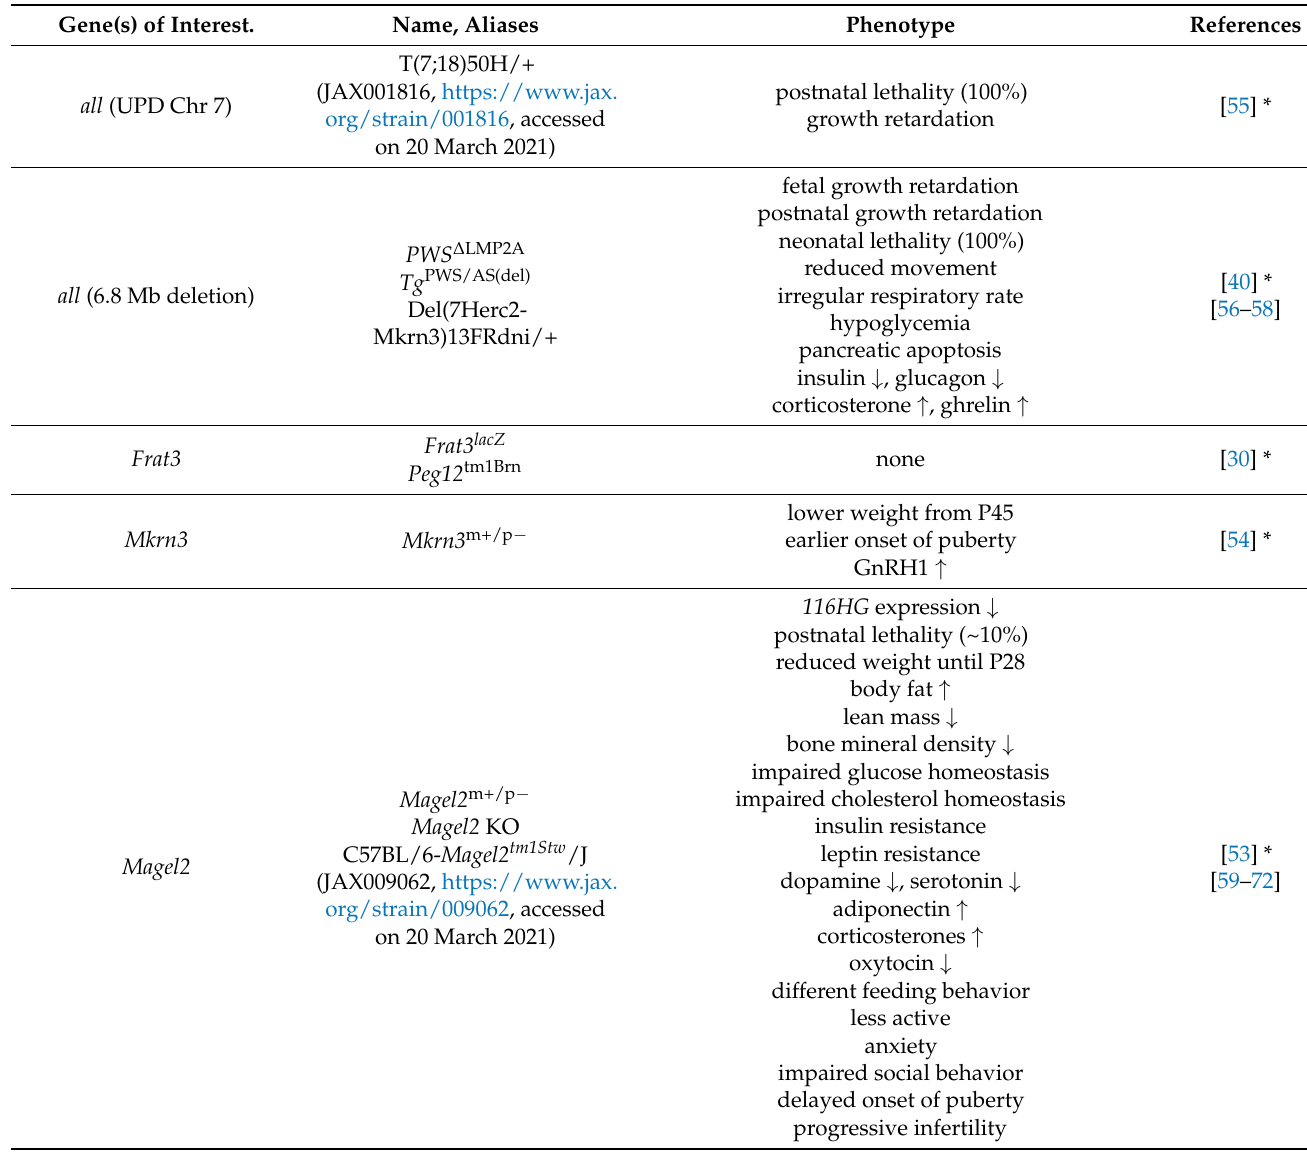
Table 1. PWS mouse models and involved